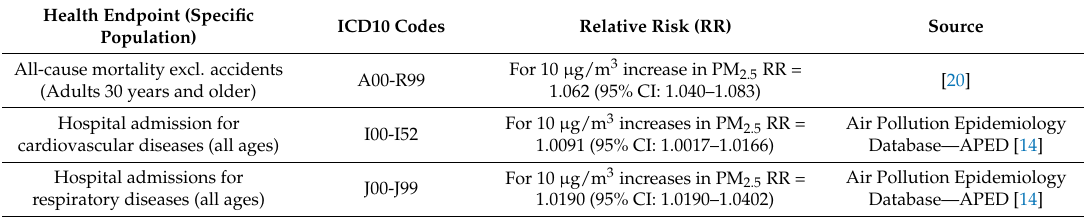
Table 2. Selected air quality indicators and PM relative